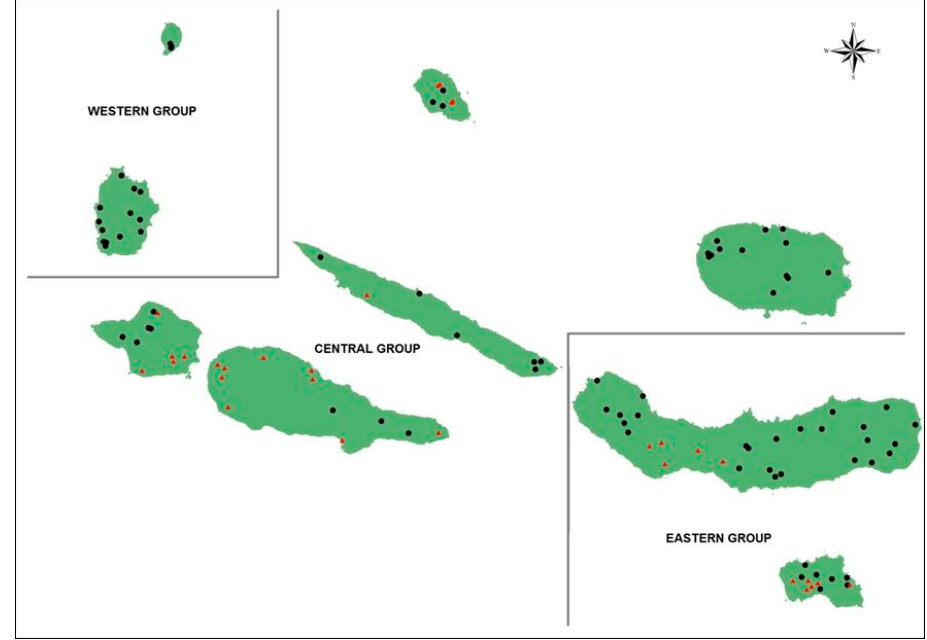
Figure 2. Location of the several springs and wells that have been monitored in the Azores archipelago (springs—black dots; drilled wells—red triangles) (map not to scale).